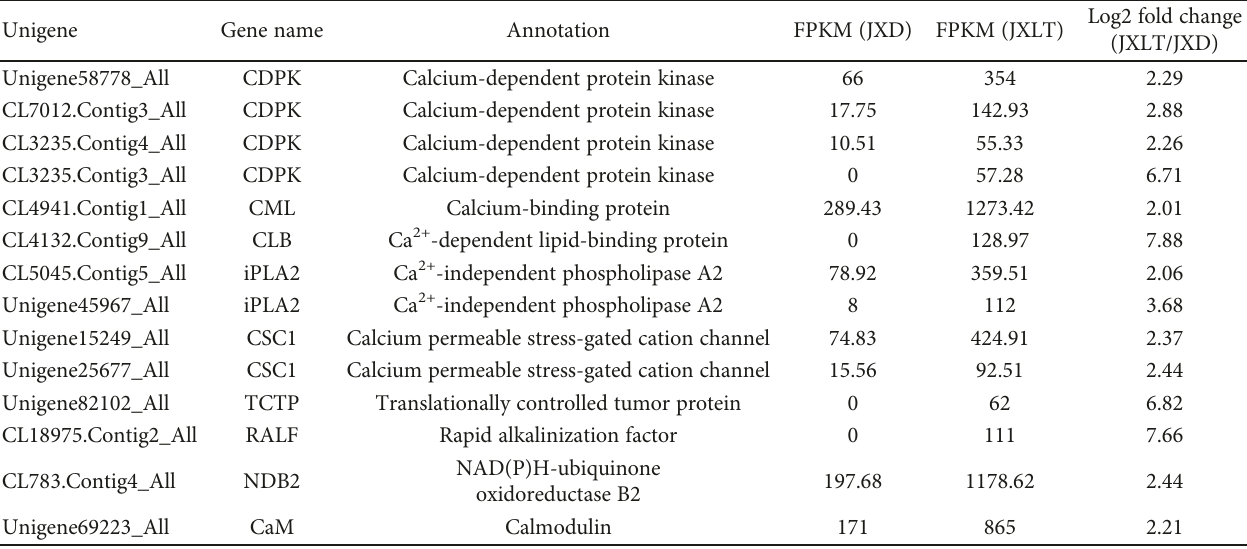
Figure 5: KEGG analysis of DEGs. (a) Pathway classi fi cation of DEGs. (b) Pathway functional enrichment result of DEGs. Table 2: Key di ff erentially expressed genes involved in calcium signal